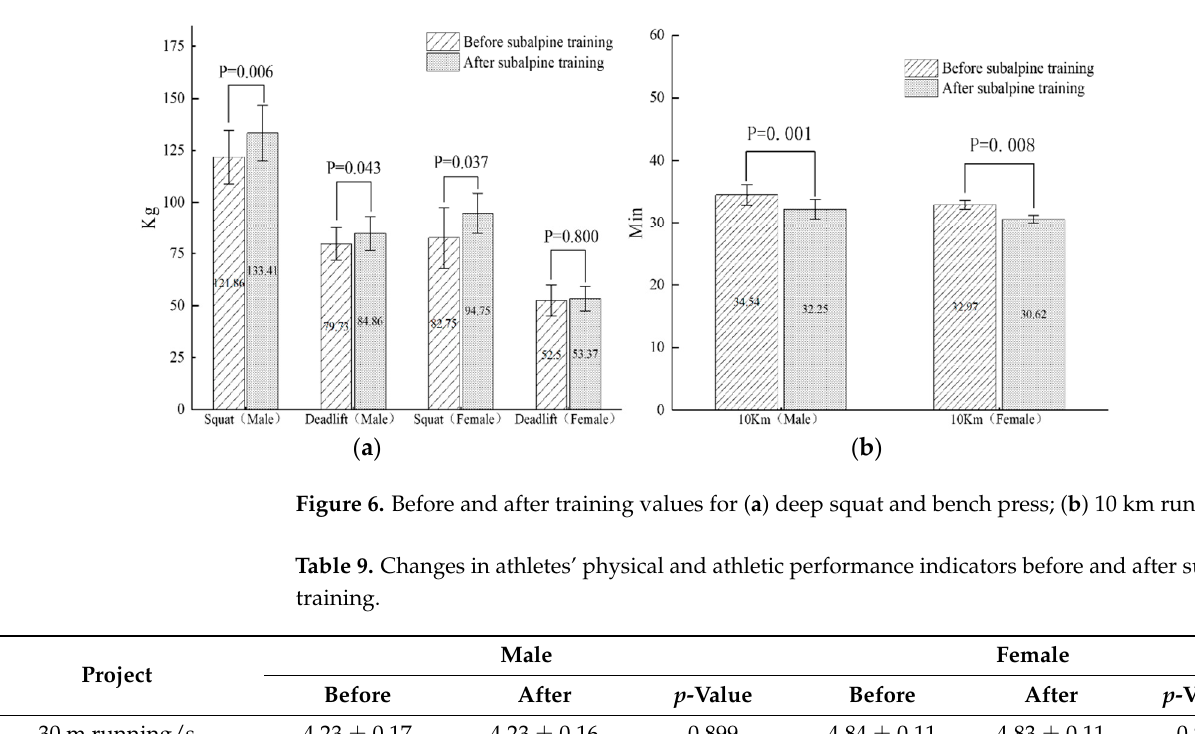
Table 9. Changes in athletes’ physical and athletic performance indicators before and after subal- pine training.